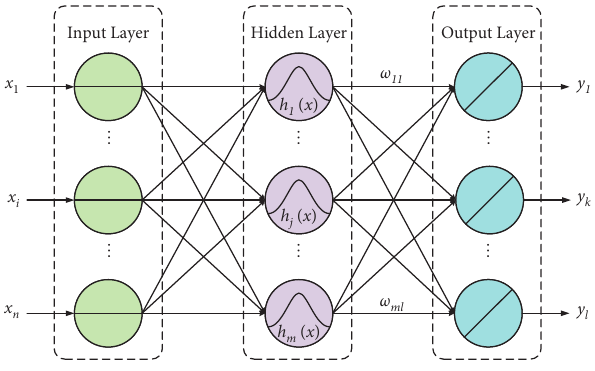
Figure 2: RBF network topology based on Gaussian